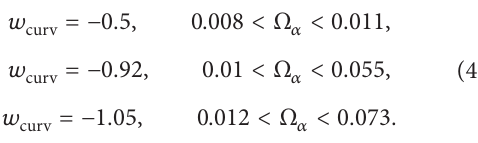
Figure 7: The phase subspace 𝑥−𝑦 that the curvature fluid plays the role of a cosmological constant. This model is cosmologically viable since there are an unstable matter-dominated point and a stable de Sitter